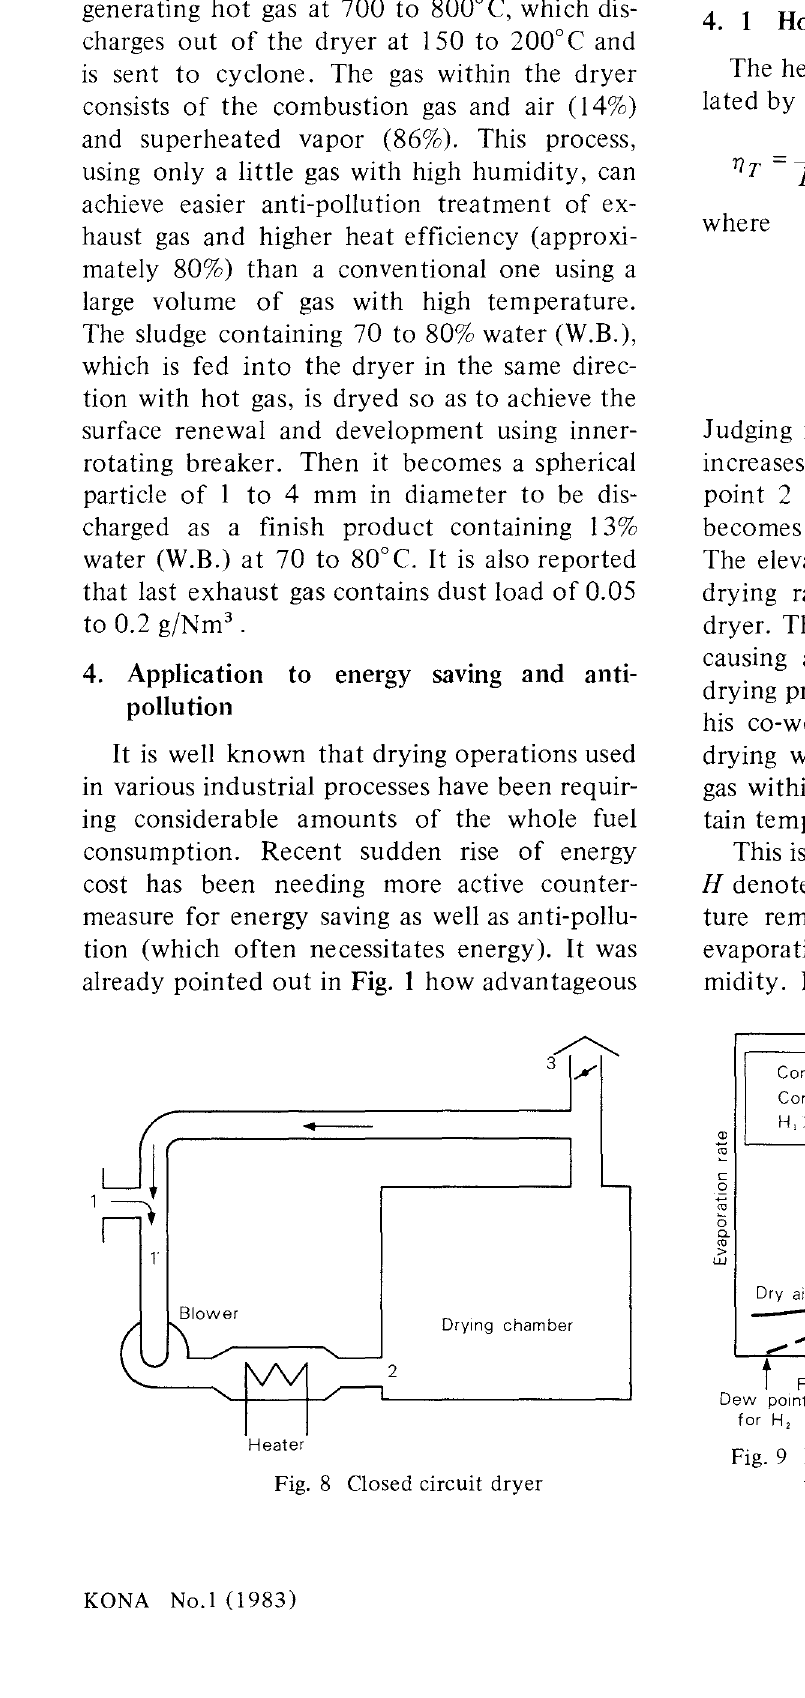
Fig. 8 Closed circuit dryer